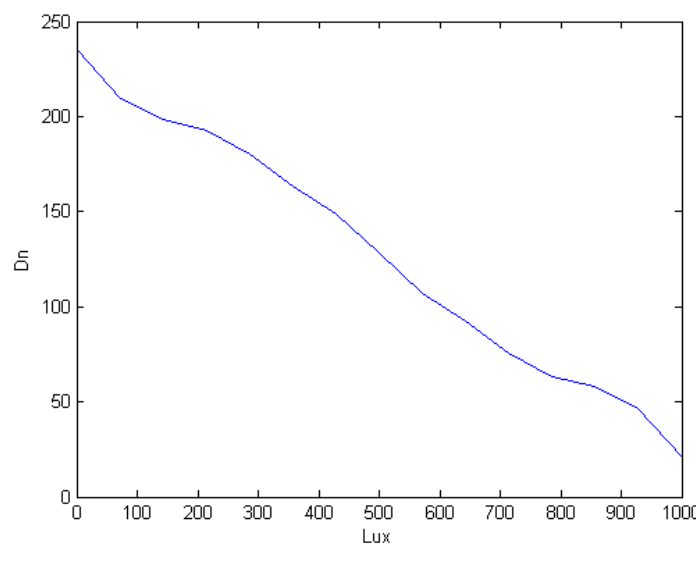
Figure 12. Lux vs. D n . Figure 12. Lux vs. 𝐷 Figure 12. Lux vs. 𝐷 𝑛 .